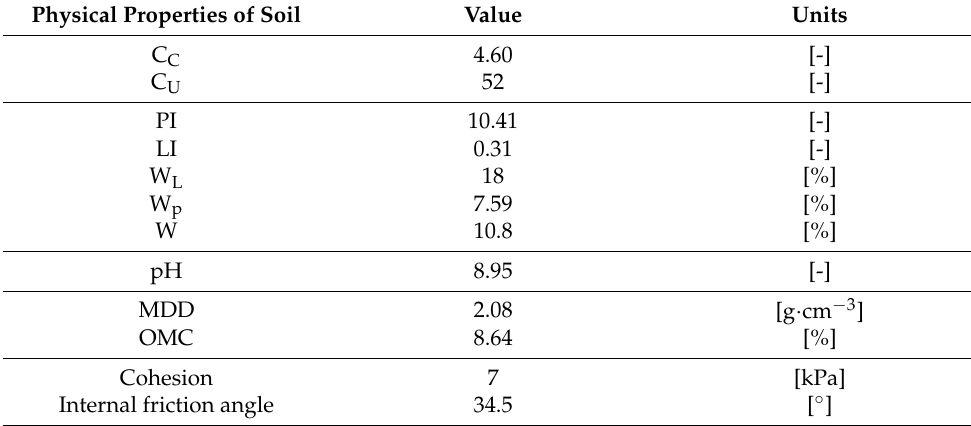
Table 1. Properties of the